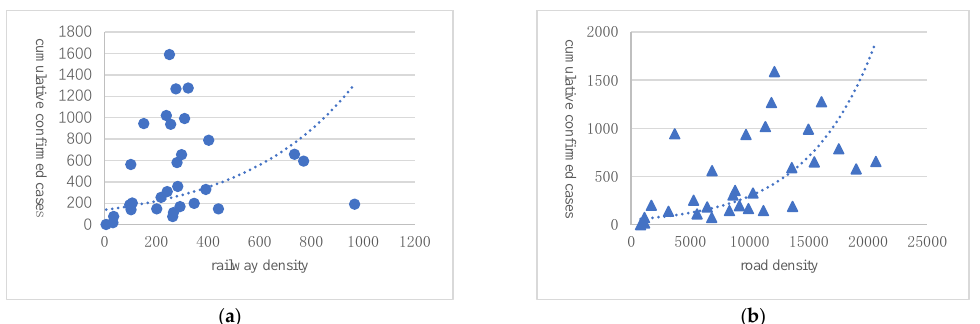
Figure 6. The confirmed cases in COVID 19 and transportation infrastructure in different prov-inces in China. Note: Railway density ( a ) and Road density ( b ) are from China’s National Bureau of Statistics. The number of confirmed cases is from China’s National Health Commission. The dashed line is the quadratic fitted line.